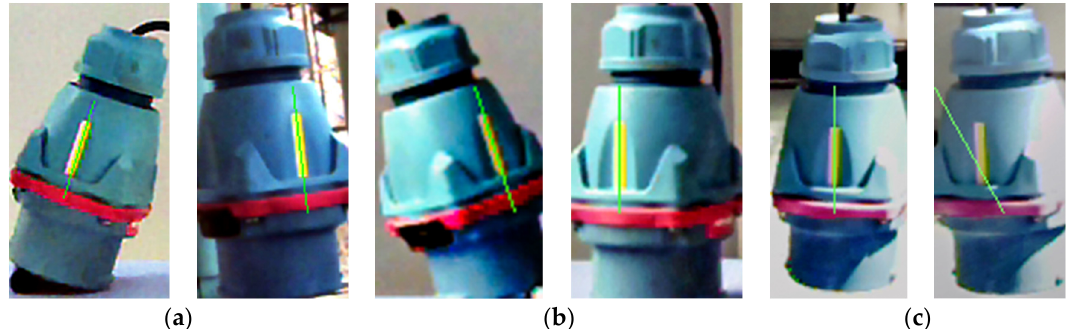
Figure 6. Beacon line feature extraction results. ( a ) weak light. ( b ) normal. ( c ) strong light.